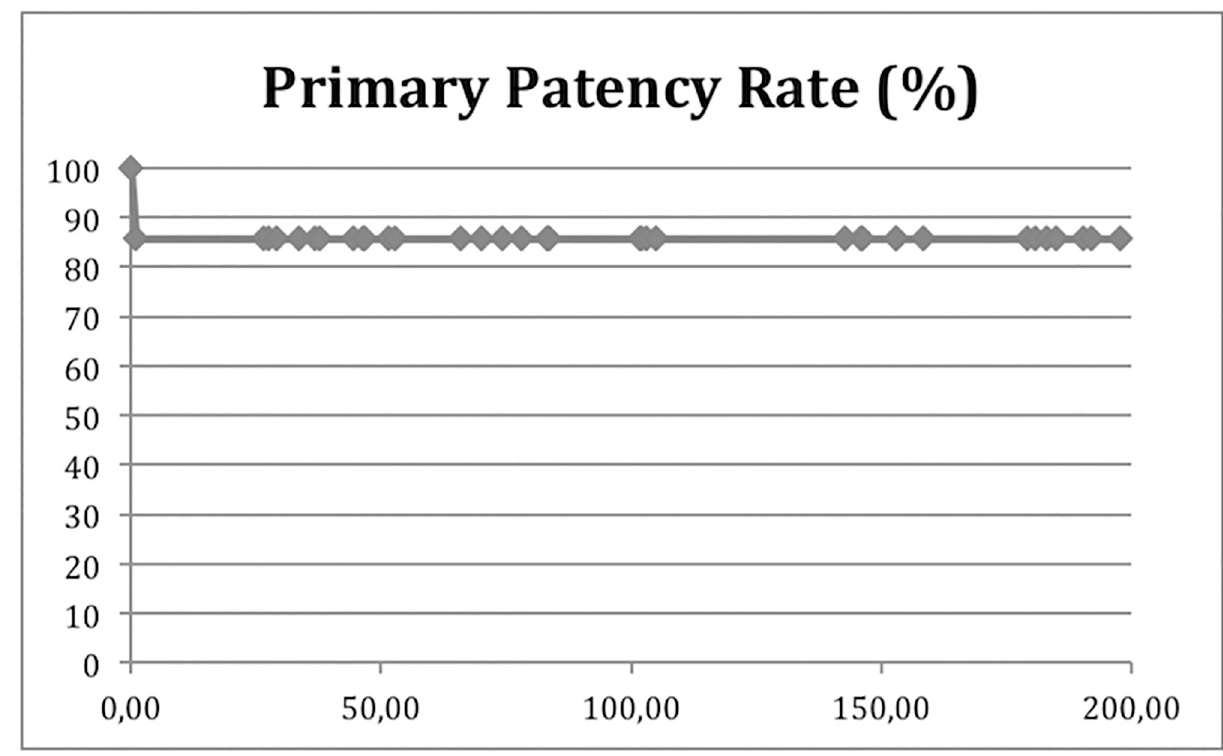
Fig 2. Patency rates. Kaplan-Meier estimation for primary patency rate in patients with iliofemoral DVT after surgical venous thrombectomy (horizontal axis: month after surgery, vertical axis percentage of open iliofemoral segments).